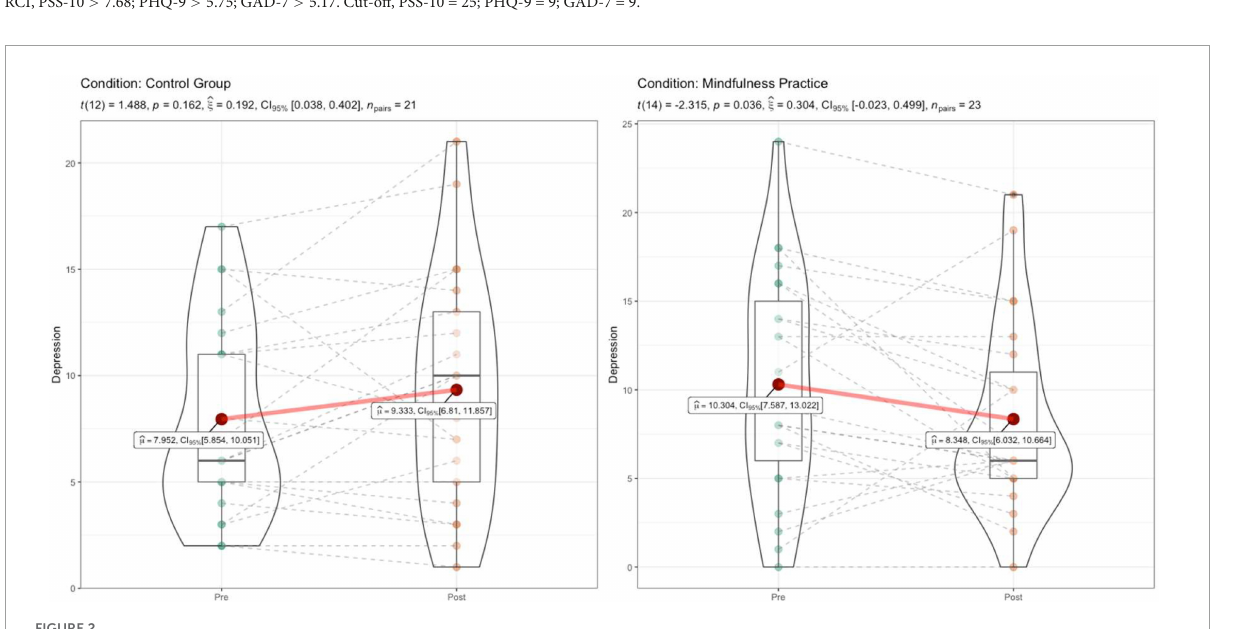
FIGURE2 Evolution of experimental and control conditions between moment T1 and Moment T2 in the depression variable.